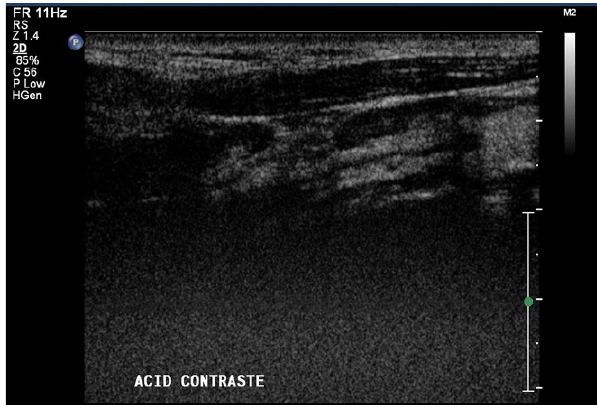
Figure 4 - Computed tomography angiography (CTA) confirming the presence of residual flow in the internal carotid artery